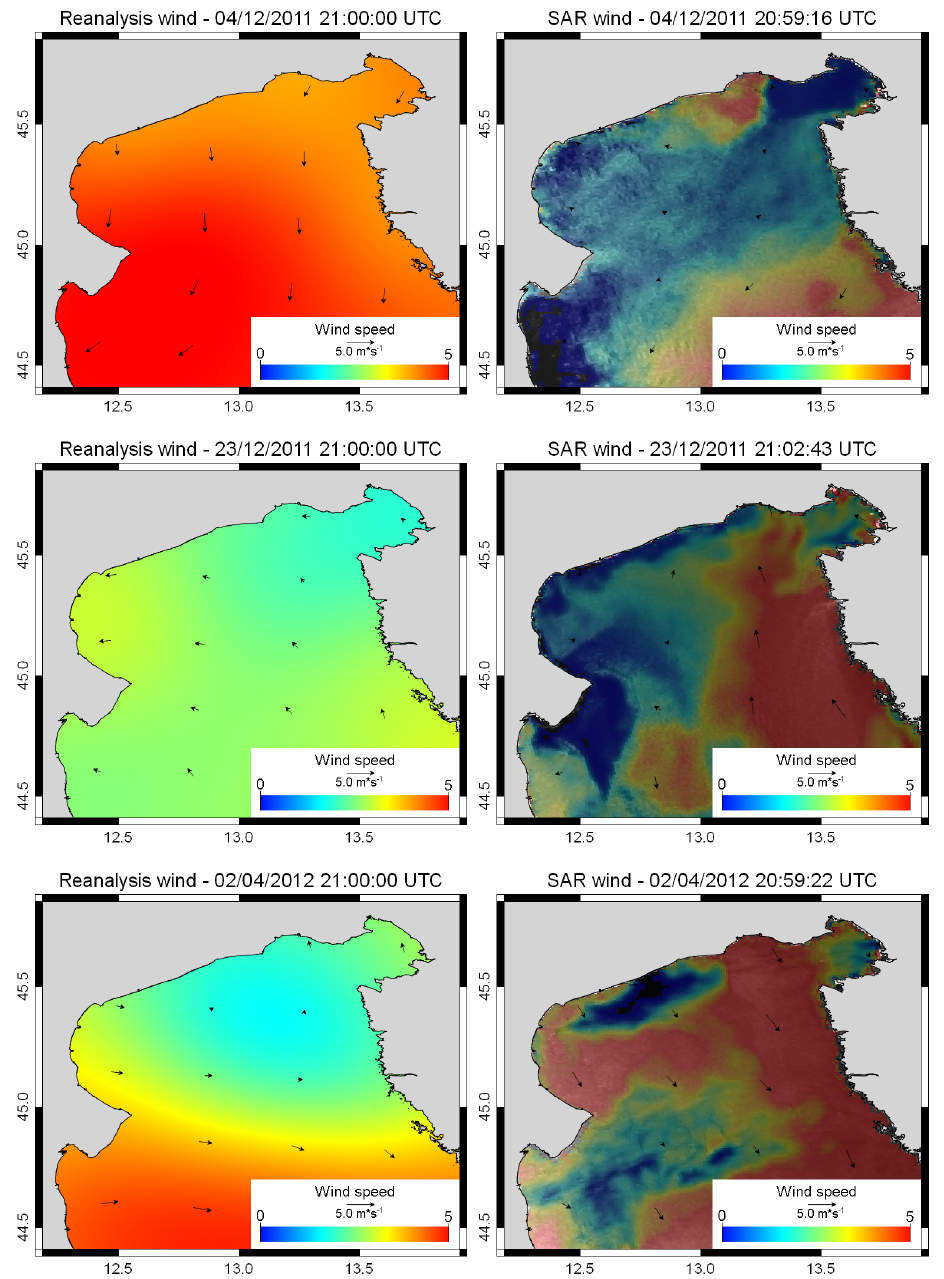
Figure 7. Examples of wind fields with similar patterns between SAR and reanalysis. SAR wind fields (right) are superimposed to the corresponding σ 0 SAR